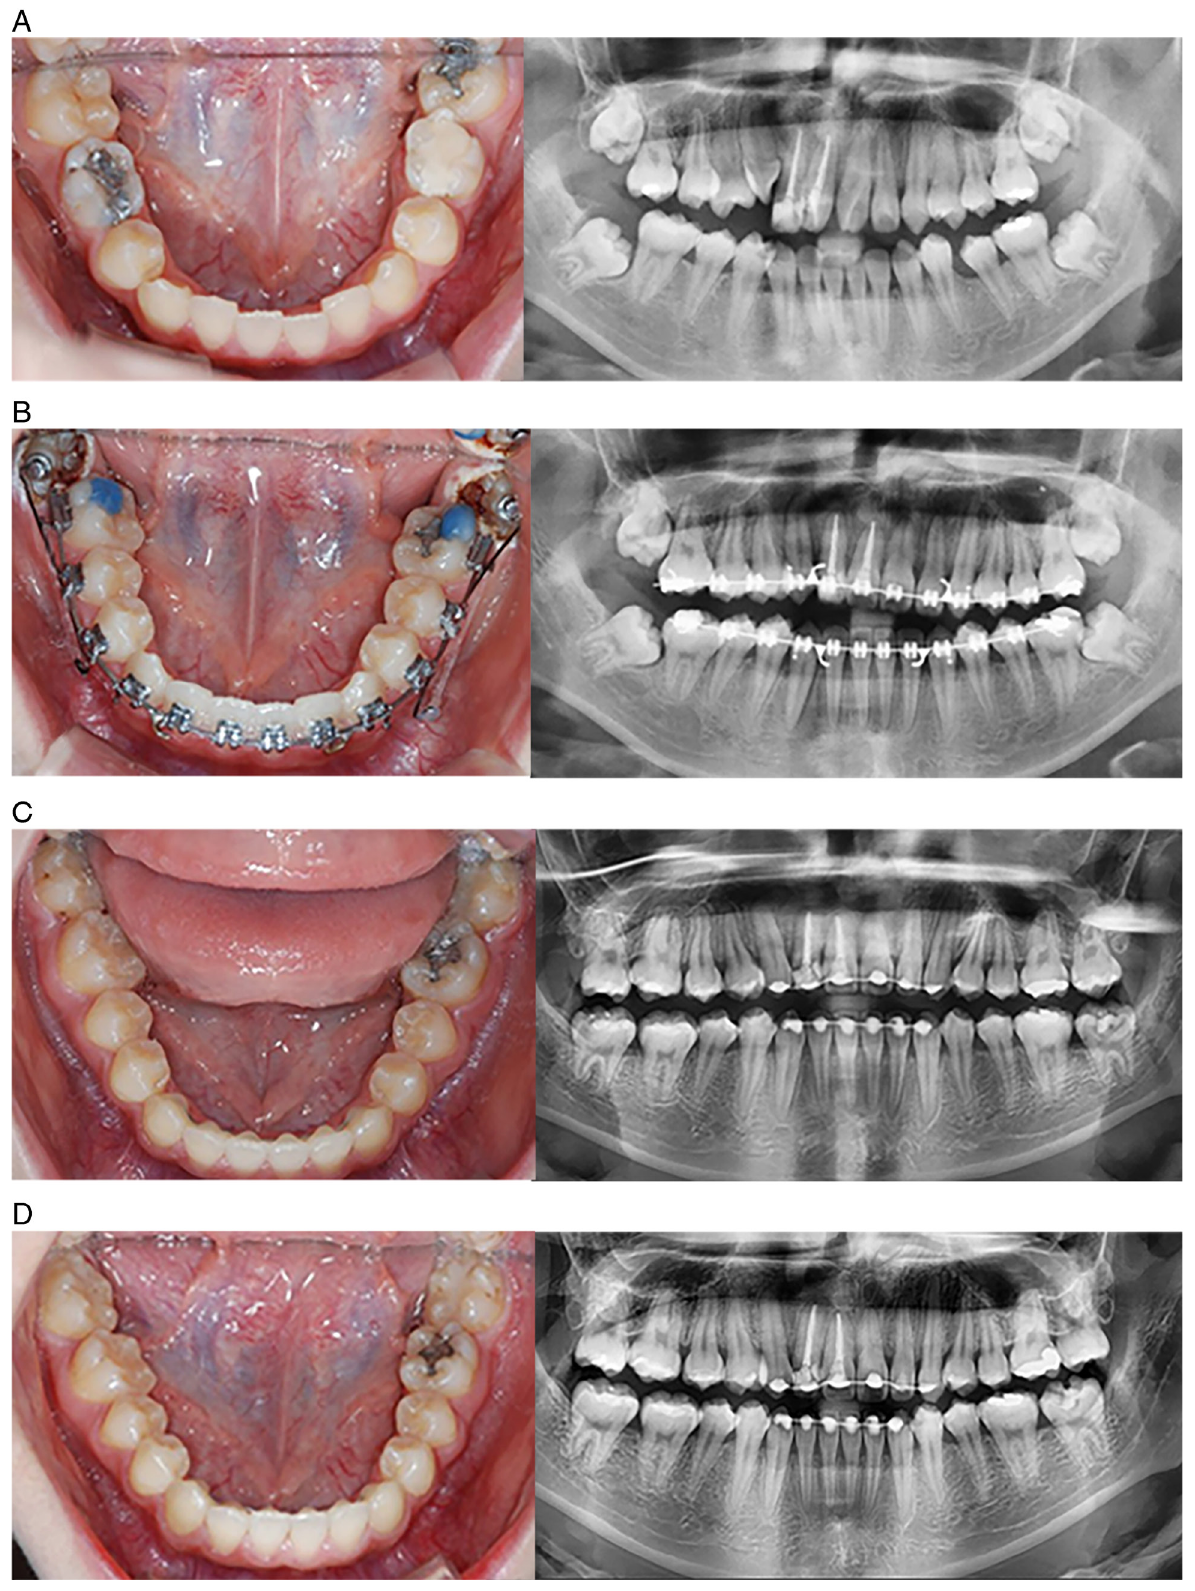
Figure 3. Case 2. A, Pretreatment. B, After 4 months of treatment, segmental wire application to the mesially angulated mandibular second molars. C, Post-treatment (after 24 months of treatment). D, After 26 months of